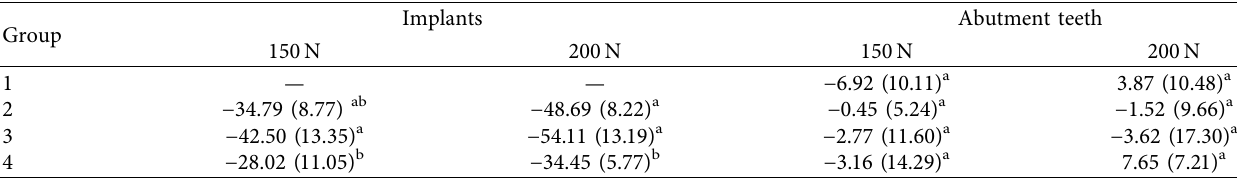
Table 1: Mean microstrain of abutment teeth and dental mini-implants under applied bilateral loading (mean strain values ( ± SD in microstrain)).